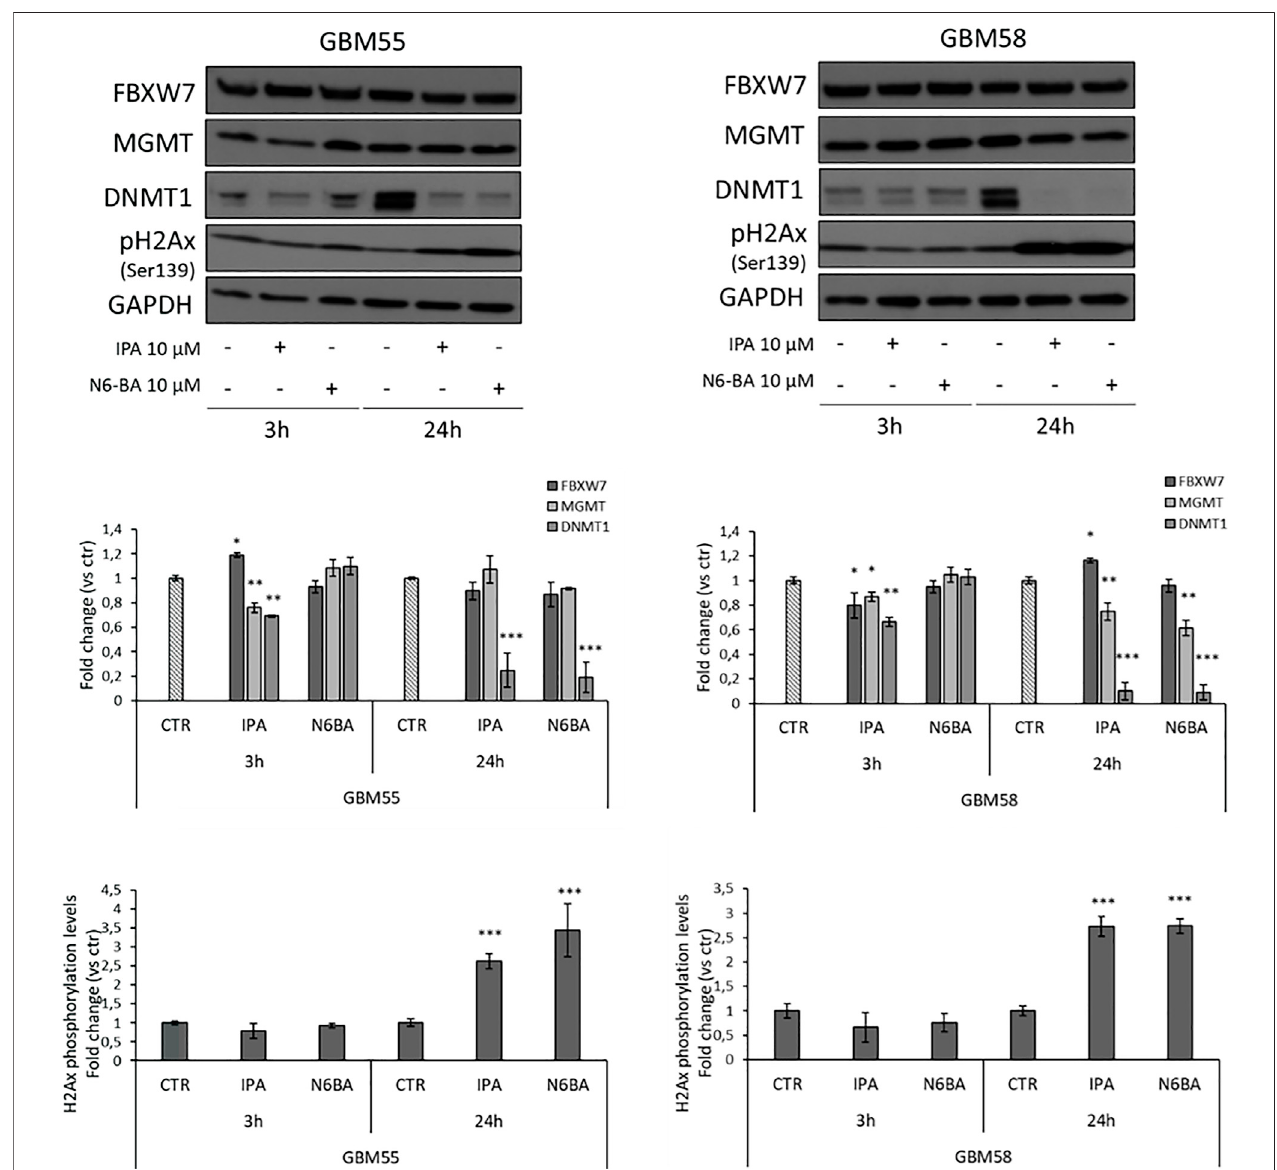
FIGURE 8 | IPA and N6-BA antitumor effects in GBM primary cell lines. Representative western blot and densitometric analysis of FBXW7, DNMT1, and MGMT expression and H2Ax phosphorylation levels in GBM primary cell lines treated for 3 or 24 h with the indicated molecules. GAPDH was used as a loading control. The histograms report the quanti fi cation of bands intensity expressed as mean ± SD of three independent experiments. * p < 0.05, ** p < 0.01, and *** p < 0.005 vs. control.